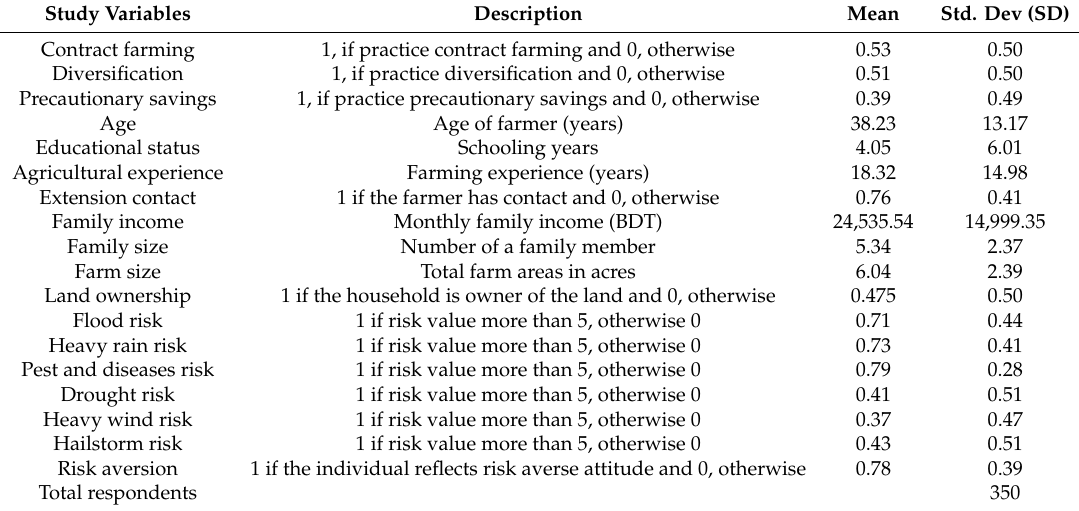
Table 1. Descriptive statistics of the variables.